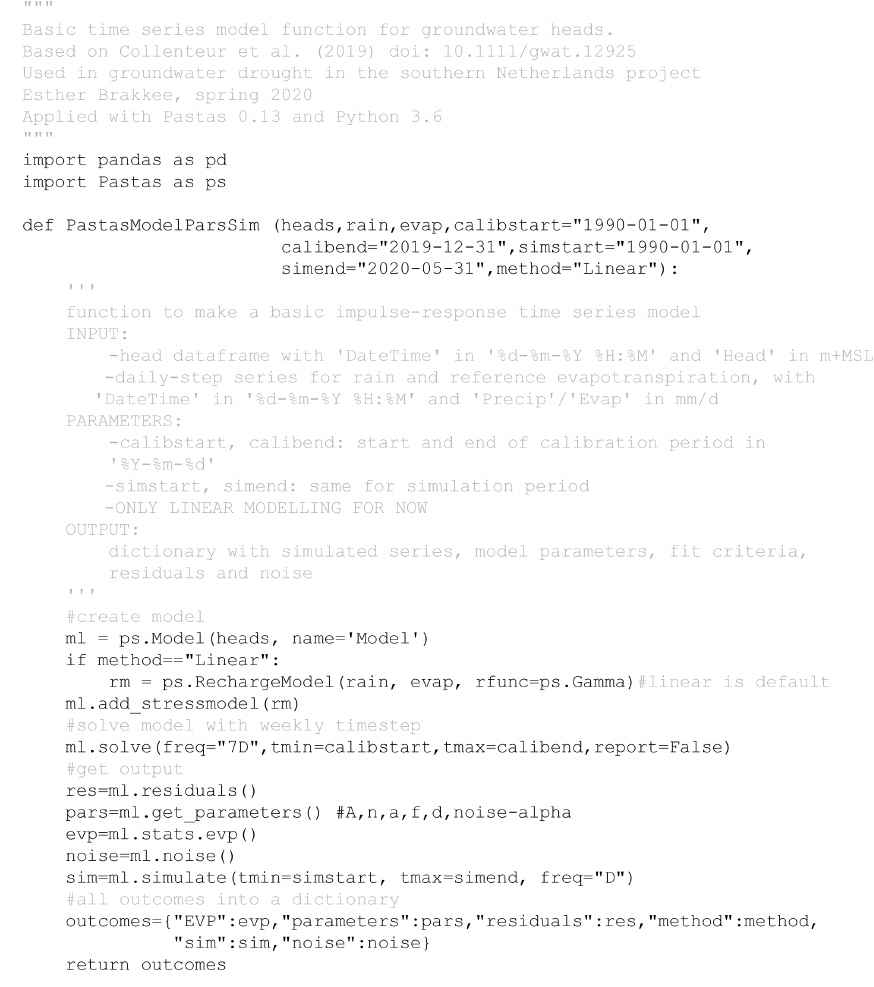
Figure A1. Python code used for building time series models with